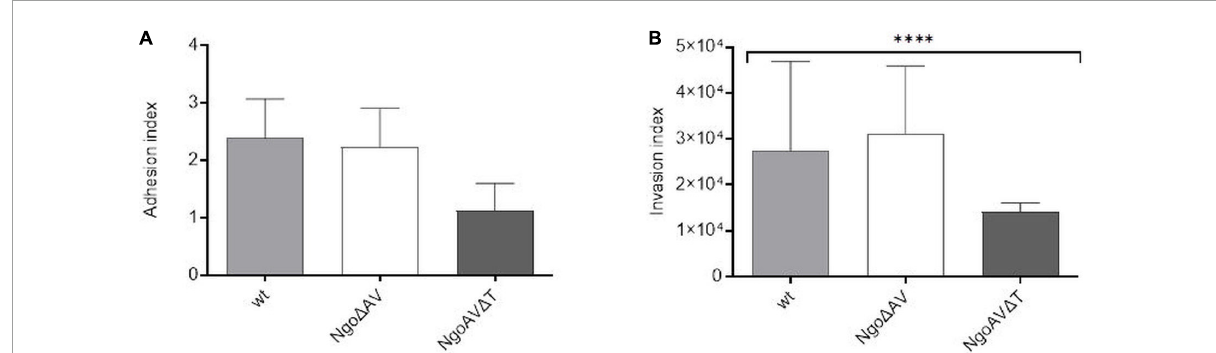
FIGURE6 Neisseria gonorrhoeae adhesion and invasion indexes to human Hec-1-B cells. Human epithelial cells were infected for 4 h with the gonococcal mutants within NgoAV RM system and wt strain. (A) The adhesion index was calculated as a ratio between the numbers of bacteria that adhered to human cells to the total number of cells used for infection. (B) The invasion index was calculated by dividing the number of gentamicin resistant cells by the adhesion index. The asterisk represents the statistical difference in comparison to the wt strain ( p < 0.05). Data are means of at least three independent experiments ( ± SD).